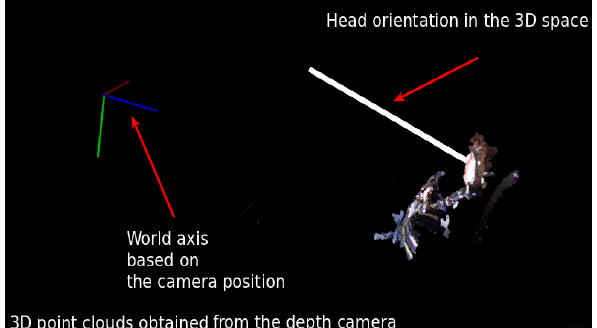
Figure 5 . 3D rendering of the system. We can observe the 3D point cloud obtained with the depth camera and the application of the head pose estimation algorithm. When a face is detected, we retrieve a vector of the head direction.